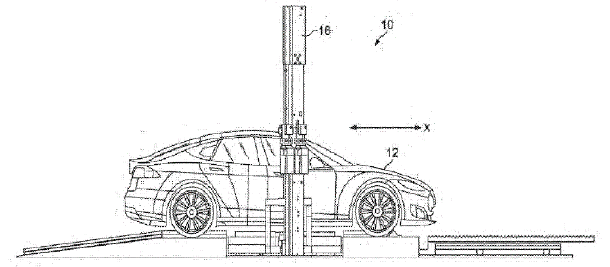
Figure 2. Diagram of an electric vehicle (EV) at a BSS ready to engage in a battery swap